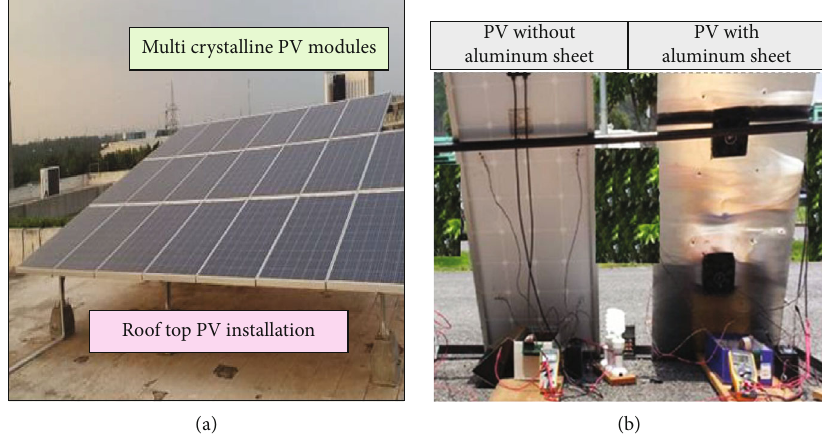
Figure 11: (a) Solar plant; (b) experimental analysis with aluminum metal